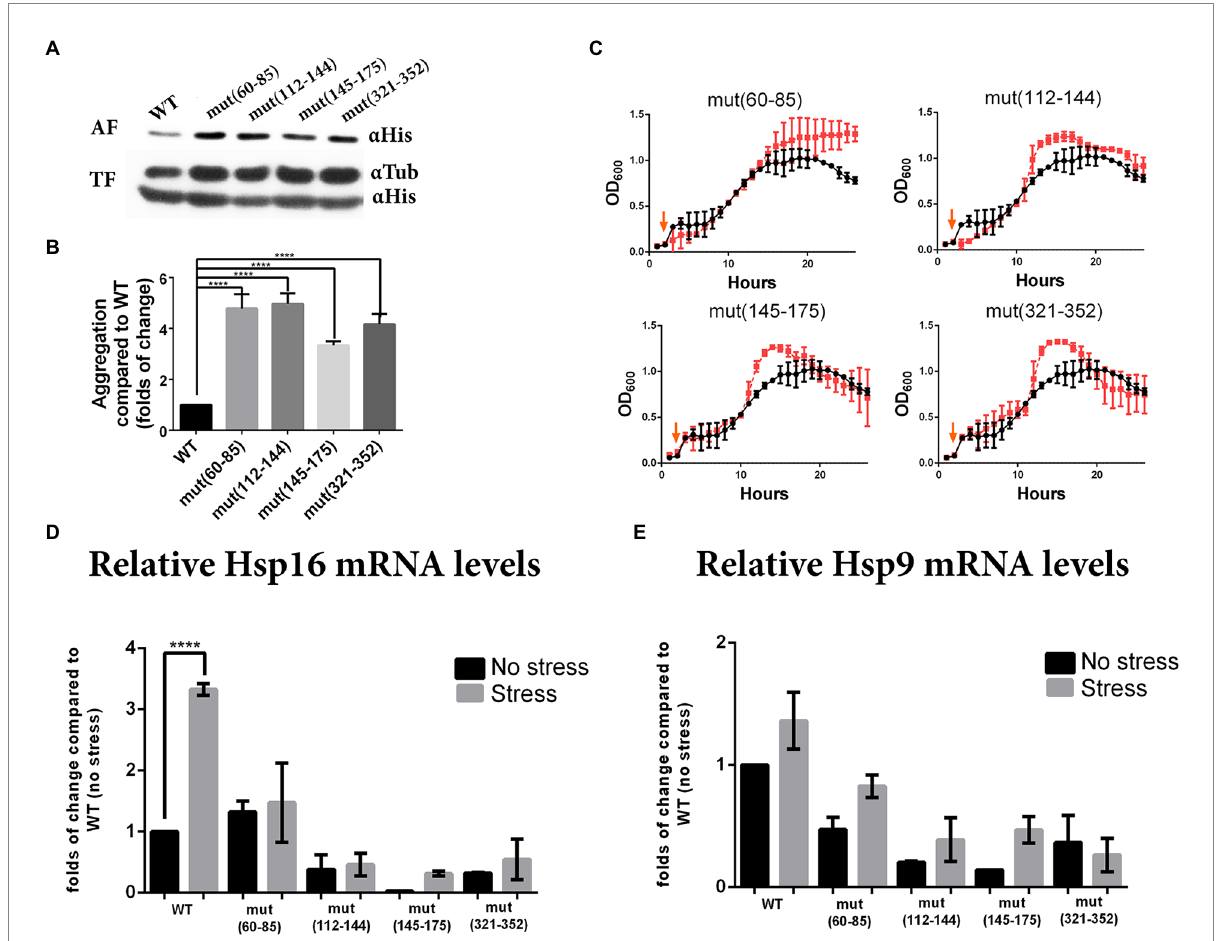
FIGURE 4 Synonymous mutations in pgk1 alter protein aggregation, response to heat stress and chaperone expression. (A) Western blot of WT and mutants ( α His) from aggregated (AF) and total (TF) protein fractions isolated from yeasts cultured in EMM2 during the late logarithmic phase in standard conditions. (B) Quantification of the aggregated fraction (aggregated Pgk1 normalized to total Pgk1) and expressed as fold-change compared to WT. Data was analyzed by one-way ANOVA (**** p < 0.0001). (C) Response to heat stress. Yeasts were grown in EMM2 at 42 ° C for 2 h, then shifted to 37 ° C (chronic heat stress, indicated with orange arrow) for 24 h. Black circles and red squares represent WT and mutant strains, respectively. (D,E) Quantification by real-time PCR of the levels of chaperones Hsp16 (D) and Hsp19 (E) mRNAs from WT and mutants, grown under standard conditions (30 ° C for 24 h, no stress, black bars) or heat stress condition (2 h at 42 ° C and 24 h at 37 ° C, stress, gray bars). The results are representative of three independent experiments, and data was analyzed by two-way ANOVA ( p <